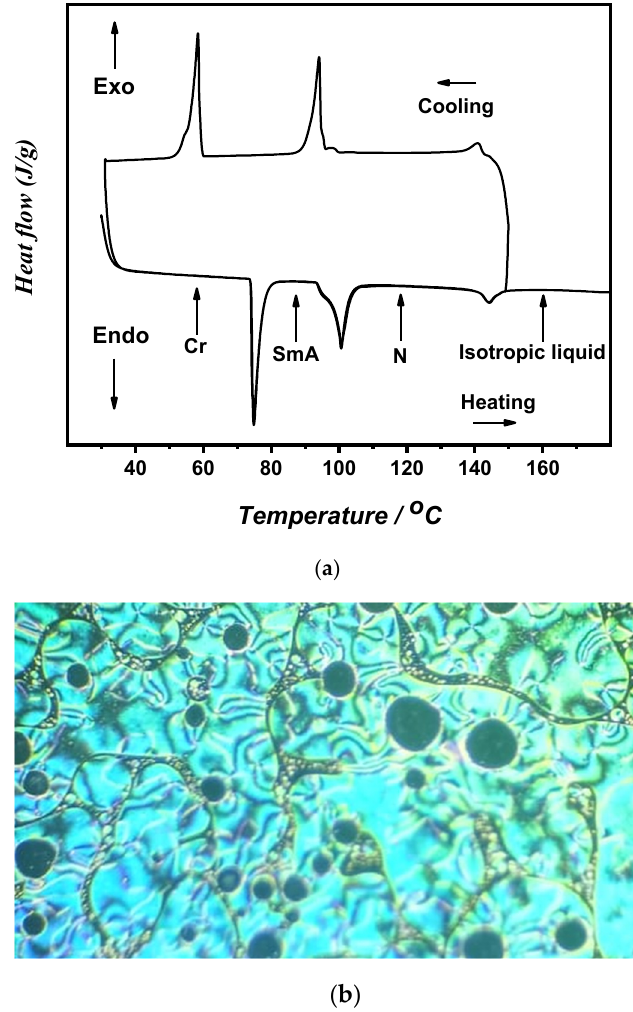
Figure 2. ( a ) DSC heating/cooling cycles of the I - C8 methyl complex liquid crystalline sample. ( b ) ( b ) POM results upon heating at 120 ◦ C revealing the nematic phase for I - C8 methyl complex liquid POM results upon heating at 120 °C revealing the nematic phase for I - C8 methyl complex liquid crystalline crystalline sample.